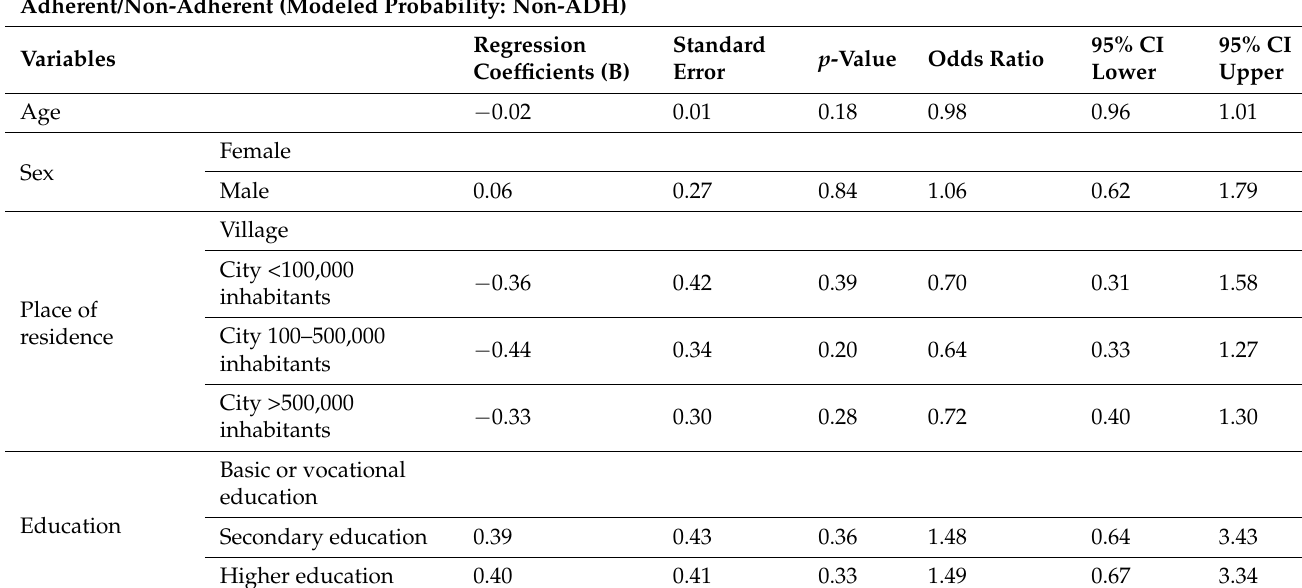
Table 5. Results of the logistic